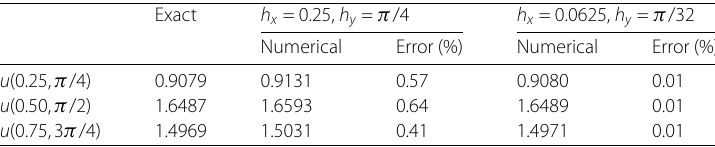
Table 7 comparison of numerical and analytical results for Example 7.4 Exact h x = 0.25, h y = π